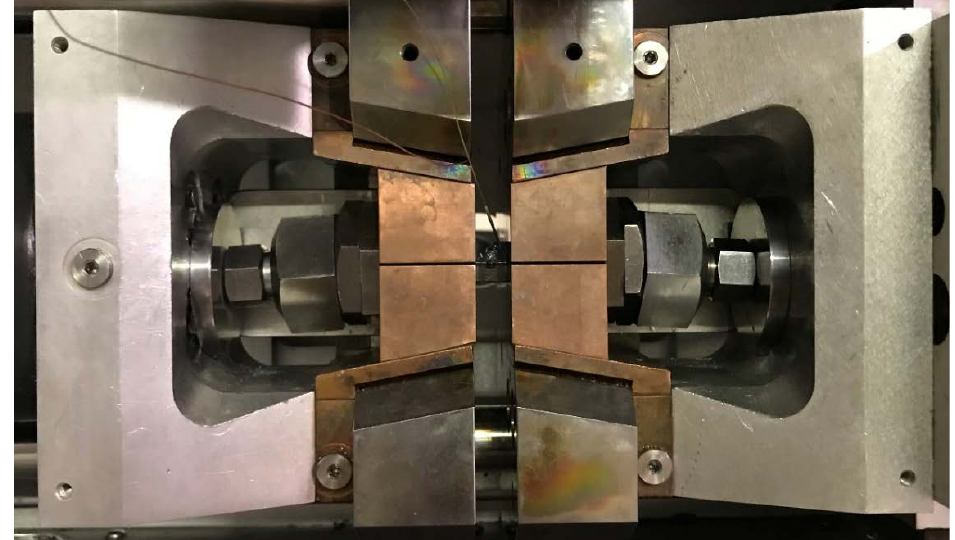
Figure 4. Clamping of the square cross-section sample in the Gleeble 3500 device.